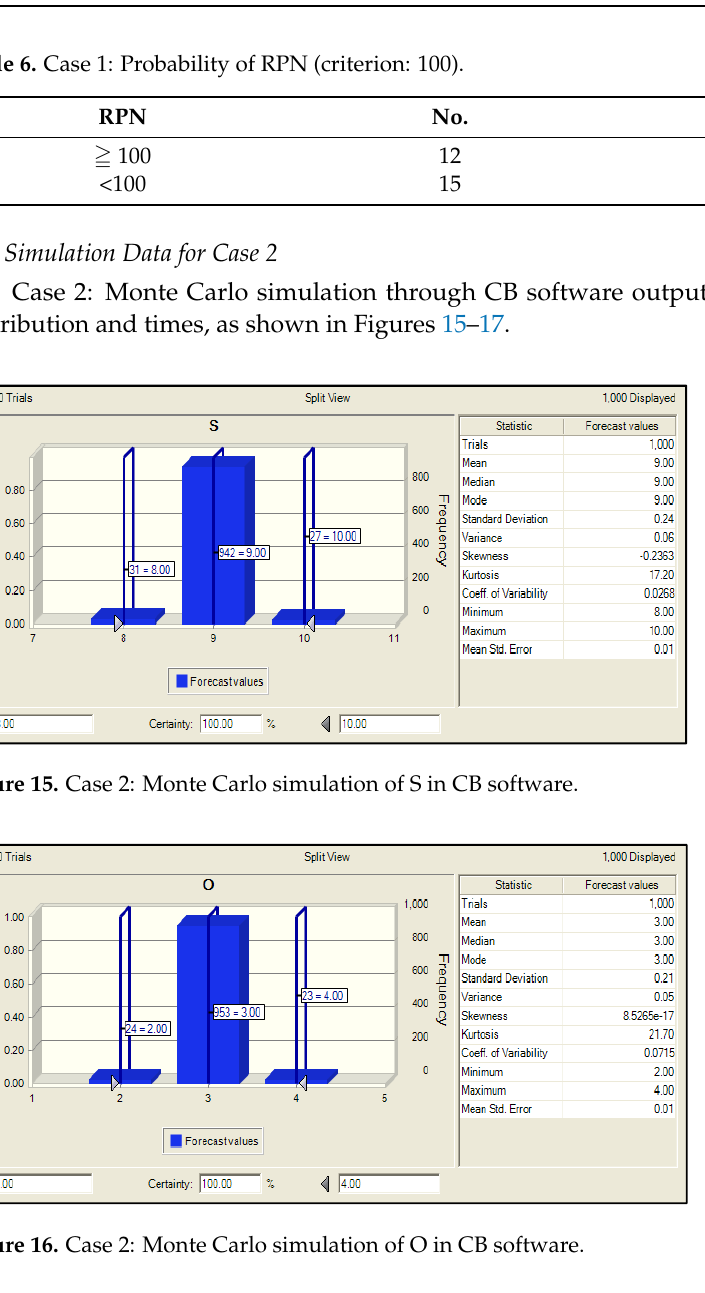
Figure 17. Case 2: Monte Carlo simulation of D in CB software. By integrating the simulation results, S, O, D probability and times are shown in Ta- ble 7. Table 7. Case 2: Probability and times of S, O, and D . Severity